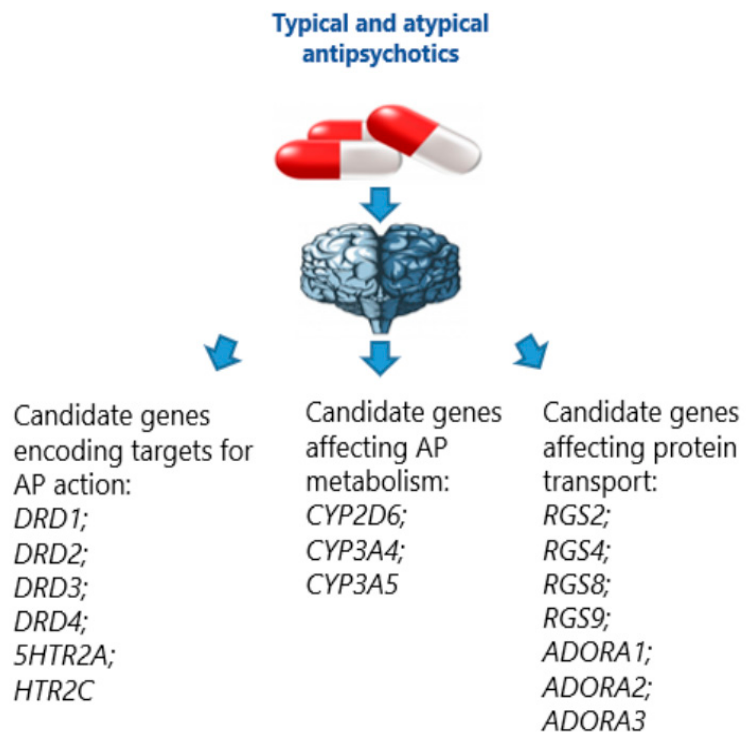
Figure 1. Candidate genes predisposed to development of antipsychotic-induced extrapyramidal syndrome.